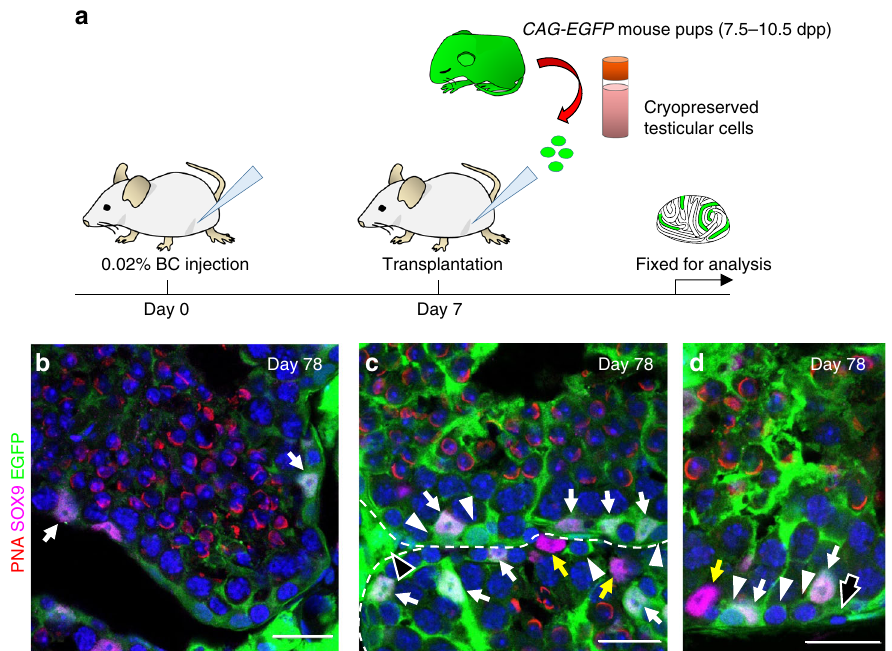
Fig. 6 Cryopreserved donor testicular cells injected 7 days post-BC treatment reconstitute multiple cell types in the testis. a Schematic representation of experimental procedures for cryopreserved testicular cell transplantation 7 days after BC treatment. b – d Host testis 71 days after transplantation of 9 dpp CAG-EGFP testicular cells that had been cryopreserved for 39 days. CAG-EGFP (green), PNA (red), SOX9 (magenta), and Hoechst (blue). b Cryopreserved donor Sertoli cells (green), co-labeled with antibodies against SOX9 (magenta; arrows), colonized and supported host spermatogenesis (PNA (red) marks round spermatids that are not green). c , d Cryopreserved donor Sertoli cells (green, with magenta nuclei, white arrows) colonized beside donor spermatogonia (white arrowheads) and supported donor spermatogenesis (PNA (red) marks round spermatids from the donor (green)). Host Sertoli cells (yellow arrows) were also present. c Donor Leydig cells (black arrowhead) and d donor peritubular myoid cell (black arrow) were also observed. Hoechst (blue). Cryopreserved donor advanced spermatogenesis with supporting cell colonization was observed in 2/3 biologically independent testis in two independent experiments. Scale bar: 25 µ